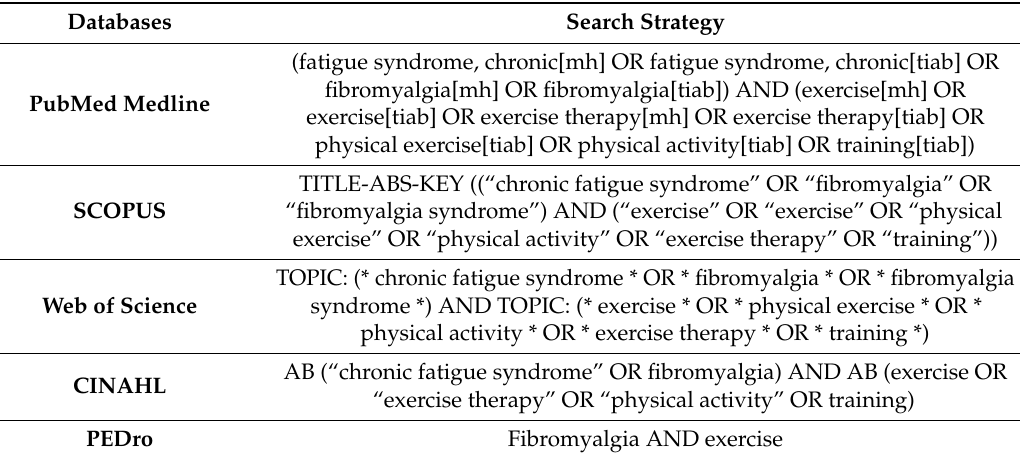
Table 1. Search Strategy for each